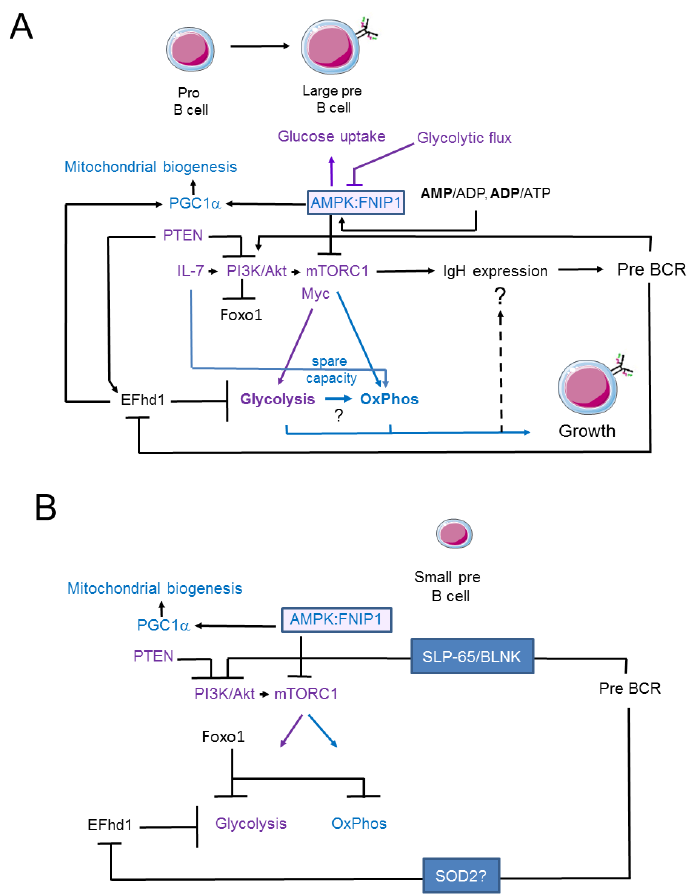
Figure 2. Relationship between oxidative phosphorylation and glycolysis during early murine B cell development. In pro- and large pre-B cells, growth is controlled by IL-7 and the pre-BCR, which lead to the activation of the PI3K/Akt/mTOR pathway. mTORC1 activates glycolysis and OxPhos and is required for the protein expression of µ HC, which controls pre-BCR expression and signalling. Whether control of µ HC protein expression occurs via glycolysis and/or OxPhos is not clear. Surface expression of the pre-BCR leads to the downregulation of EFhd1, a Ca 2+ -binding protein localized on the inner mitochondrial membrane. EFhd1 suppresses glycolysis in transformed pro-B cells and is induced by PTEN. In primary pre-B cells, overexpression of EFhd1 induces PGC1 α , which is also controlled by AMPK1, a negative regulator of anabolic pathways and a positive regulator of catabolic pathways. AMPK activity is controlled by ADP/AMP and ATP/ADP ratios and fructose 1,6 bisphosphate and is an indicator of glycolytic flux. AMPK activity is also modified by FNIP1. Loss of FNIP1 by genetic ablation leads to anabolic exhaustion in pro-/pre-B cells. IL-7 increases the mitochondrial spare capacity in pre-B cells. ( A ) The network in pro- and large pre-B cells with an activated PI3K pathway and inactivated Foxo1; and ( B ) the network in small pre-B cells, in which the PI3K and mTORC1 pathways are inactivated but Foxo1 is activated. It is unclear whether large pre-B cells depend solely on glycolysis or whether glycolytic pathways are mutually linked to